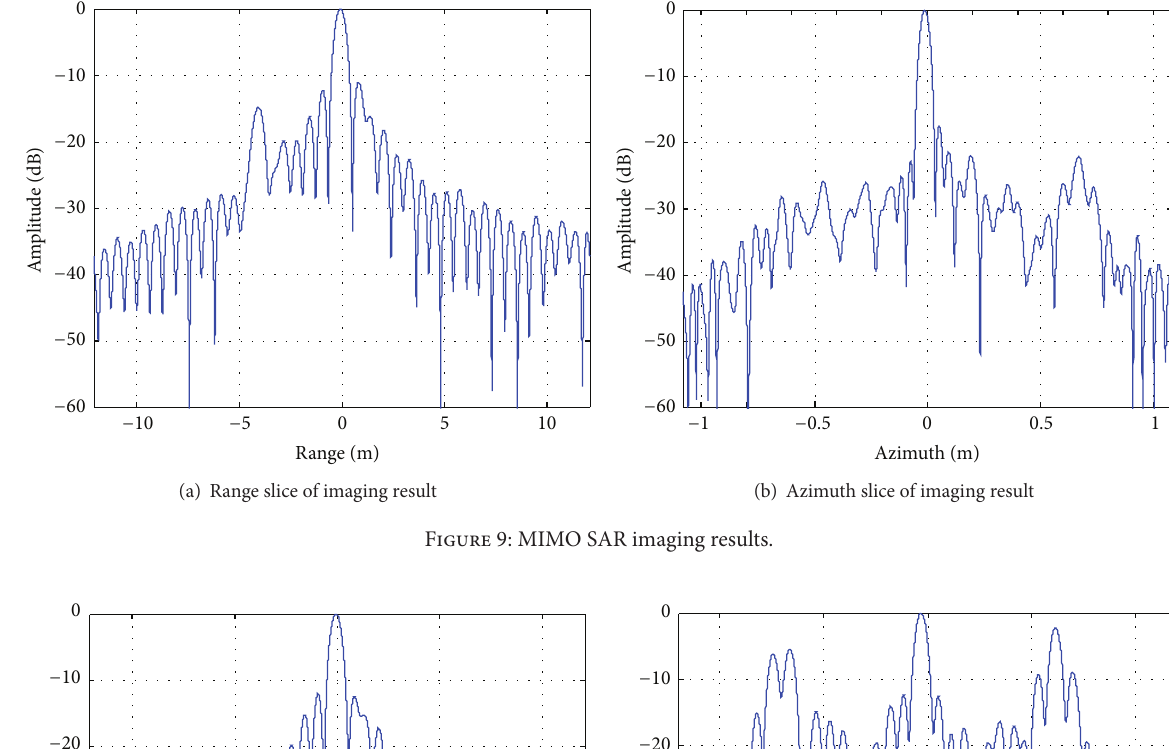
Figure 9: MIMO SAR imaging results.